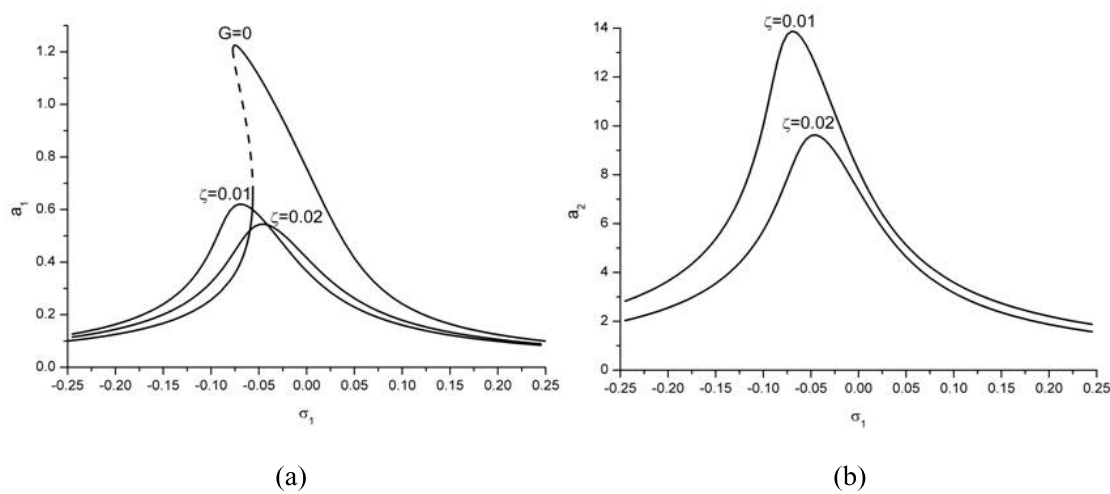
Fig. 4. Effect of varying the absorber’s damping on the frequency-response curves of (a) the plant and (b) the absorber when f = 0 . 025 , G = 0 . 005 and ν 2 = − 0 . 02 .